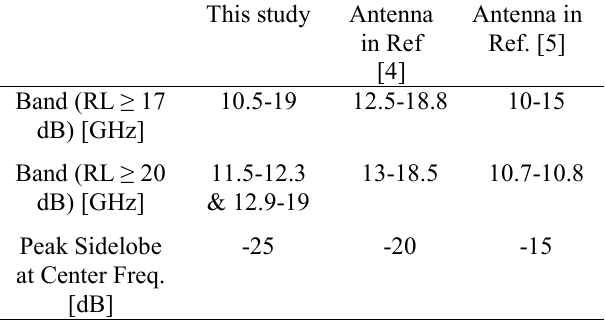
Table 3: Comparison of return loss frequency band and peak sidelobe level at center frequency.